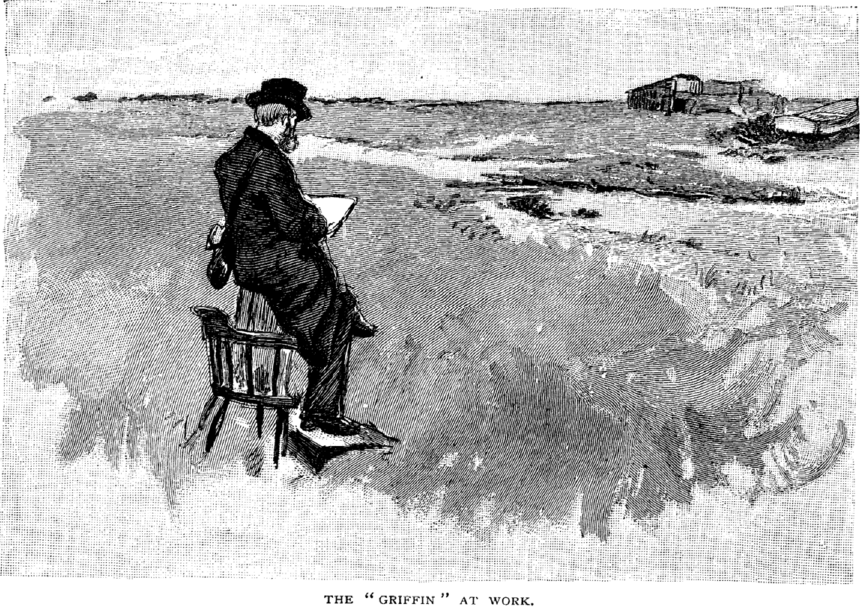
Figure 15. Engraving after a drawing by Edwin Austin Abbey, The “Griffin” at Work , published in “The Tile Club at Play”, Scribner’s Monthly , February 1879. Hathi Thrust Public Domain